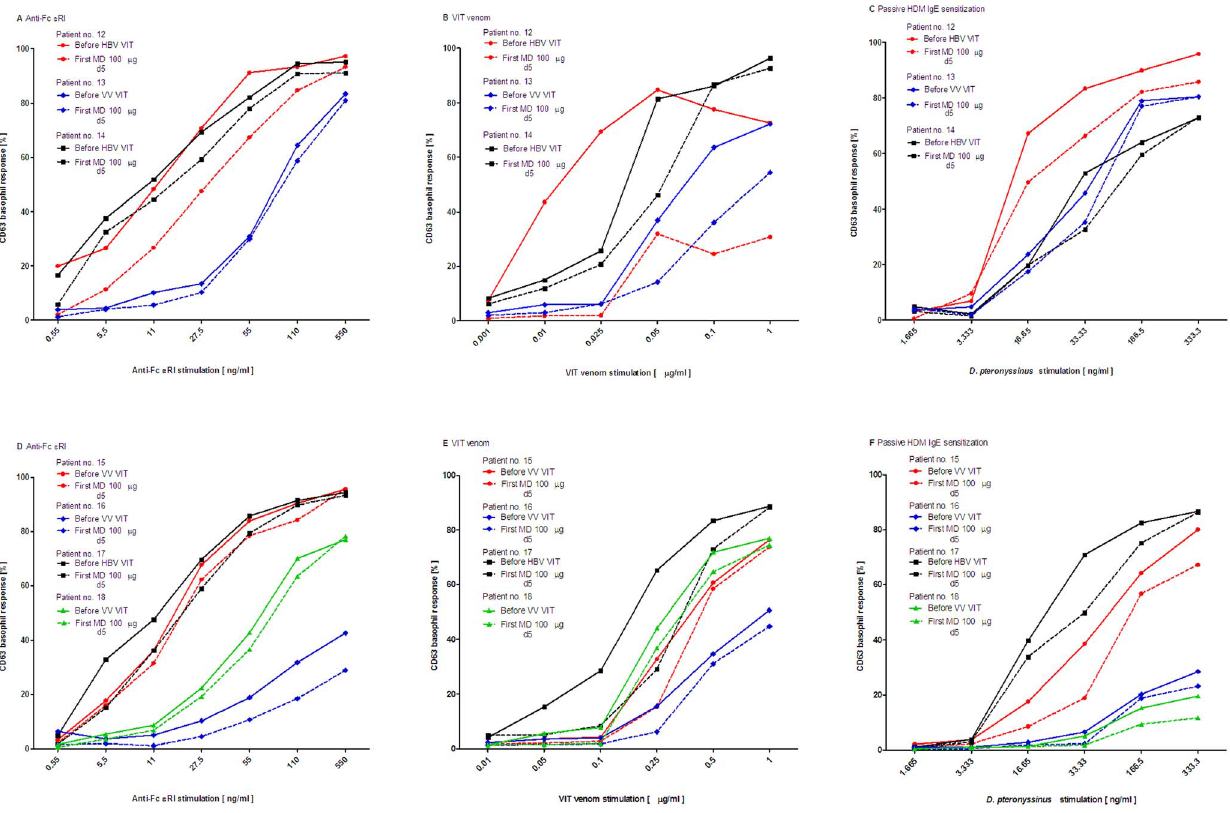
Figure 4. A–F. Passive IgE sensitization (dose-response curves). CD63 basophil dose-response curves in patients nos. 12–18 in A and D to anti-Fc e RI in B and E to VIT venom and in C and F after passive IgE sensitization of stripped basophils also to house dust mite stimulation, all before treatment and the first maintenance dose of ultra-rush VIT.